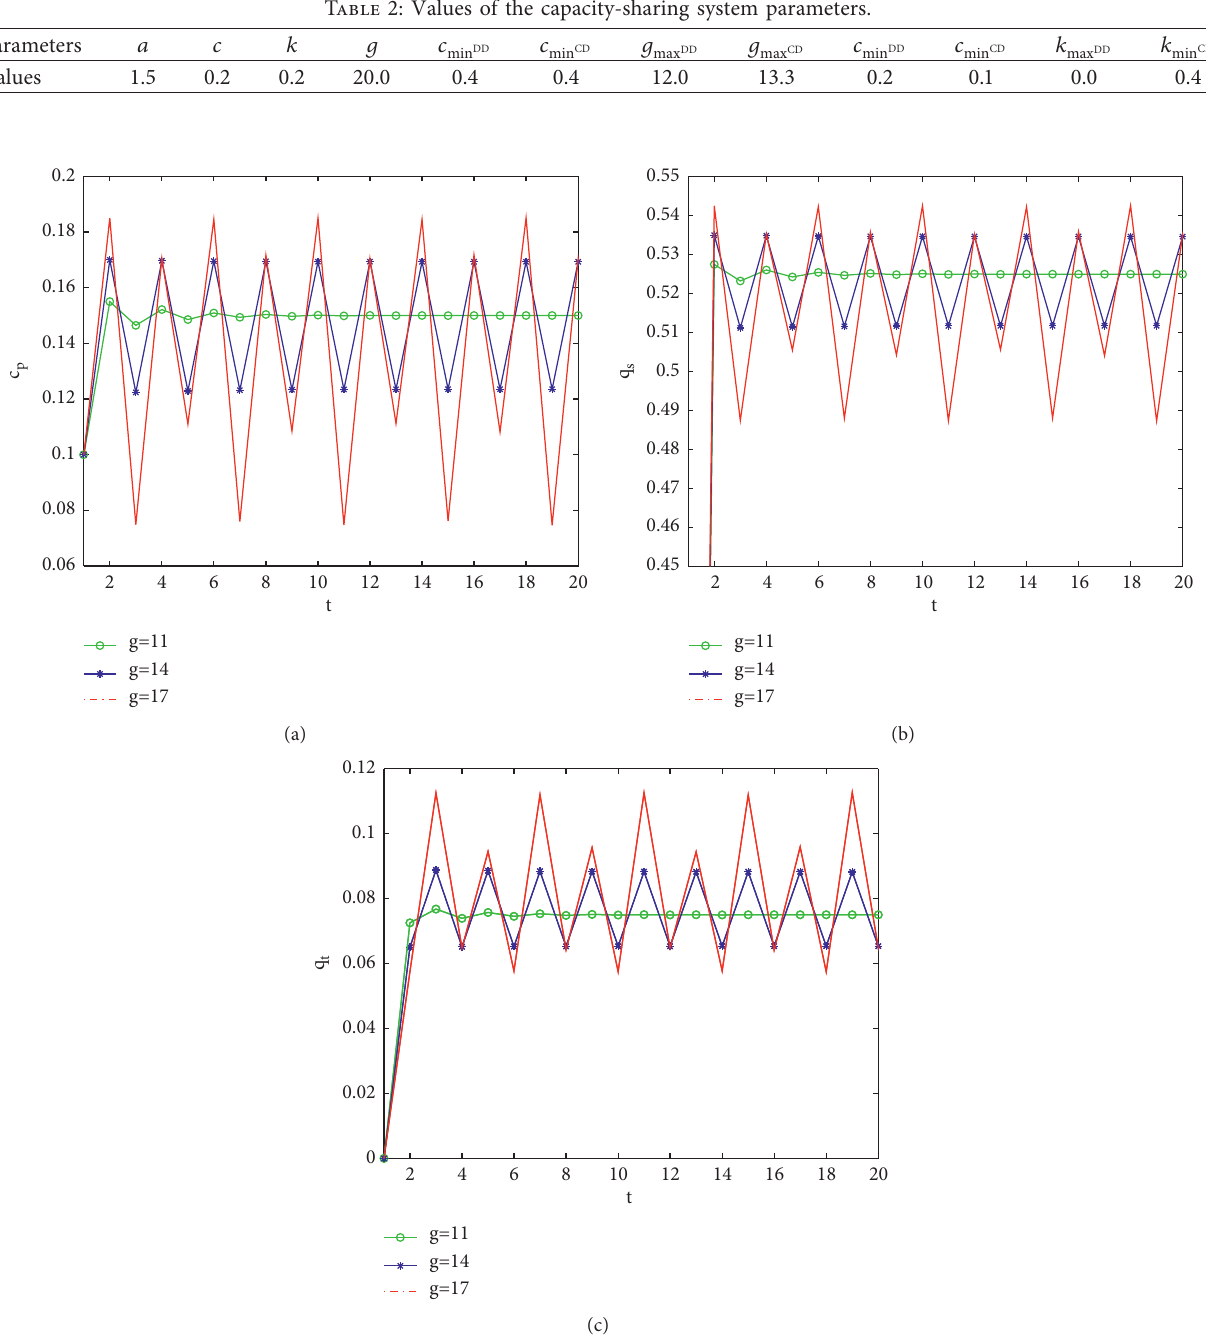
Figure 4: Time series for different states ( g � 11 , 14 , 17 ) under CD: (a) c